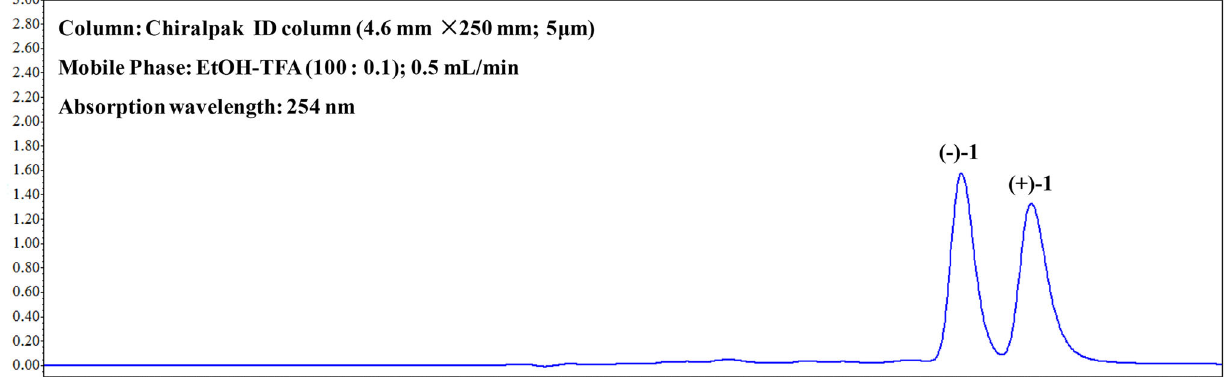
Fig. 3 Chiral analysis of zanthonitidine A ( 1 )